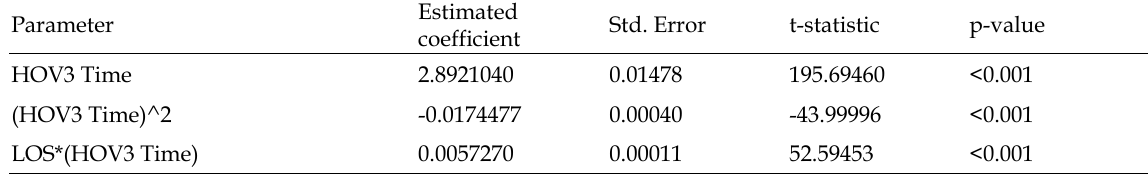
Table 1: In Vehicle Time (IVT) Functions for (a) Peak and (b) Off-Peak Time a) Peak Period Model (N=50,727)